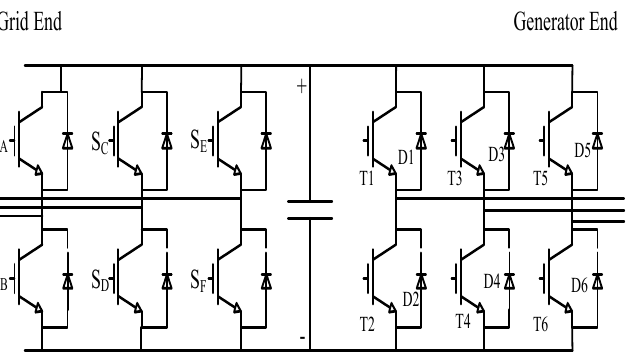
Figure 7. A representative diagram of a two-level voltage source converter